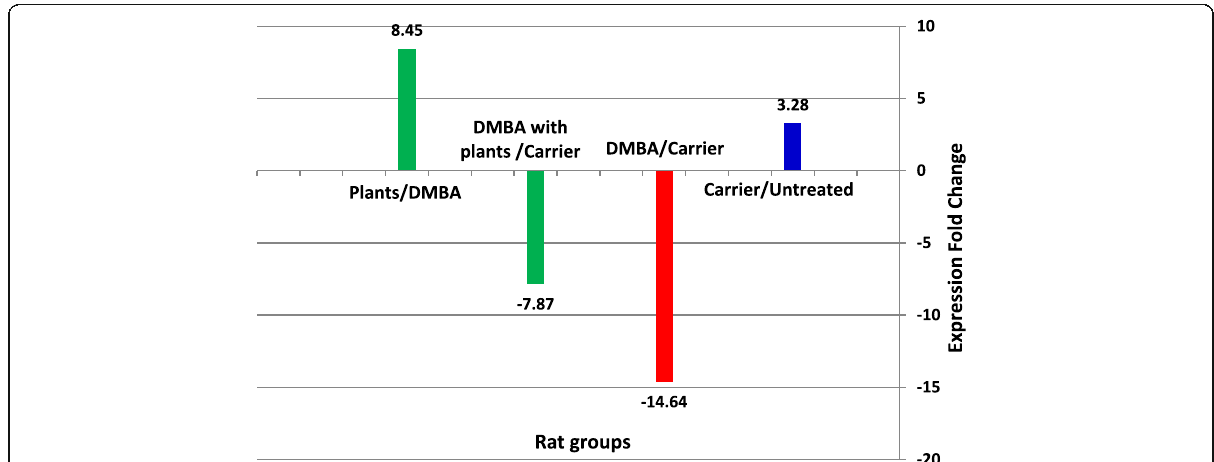
Fig. 10 Expression fold change of S1PR1 in rat groups: carrier (compared to untreated), DMBA (compared to carrier), DMBA with plants (compared to carrier), and plant mixture (compared to